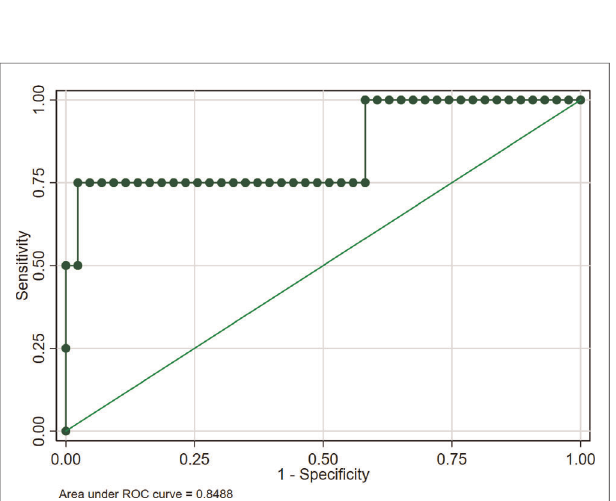
FIGURE 3 | Receiver operating characteristic curve for the predictors of recurrence after conservative surgery of intestinal deep endometriosis.